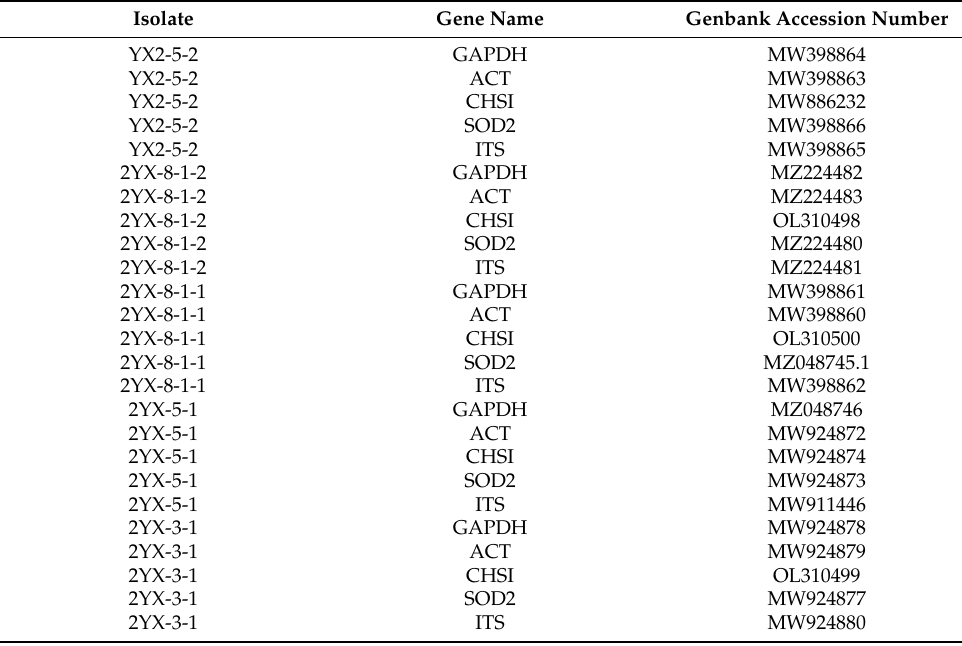
Figure 3. A Maximum Likelihood phylogenetic tree using isolates YX2-5-2, 2YX-8-1-2, 2YX-3-1, 2YX- 8-1-1, 2YX-5-1 and type strains of the Colletotrichum gloeosporioides complex based on the combined CHS-1, ACT, ITS, SOD2 and GAPDH gene sequences. Table 2. GenBank accession number of the five isolates.